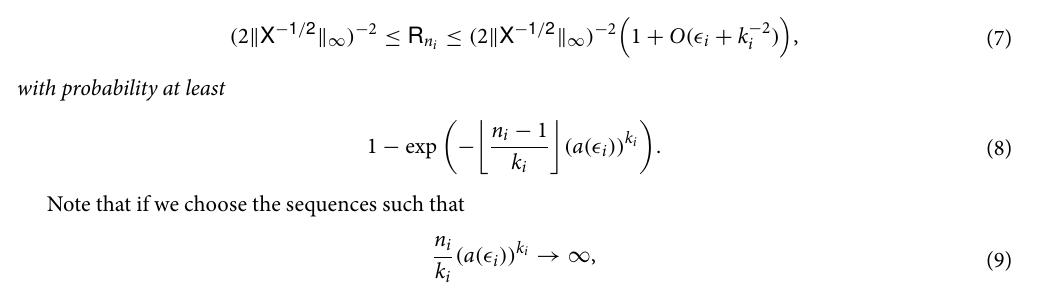
, R n converges to 1/4 with probability → ∞